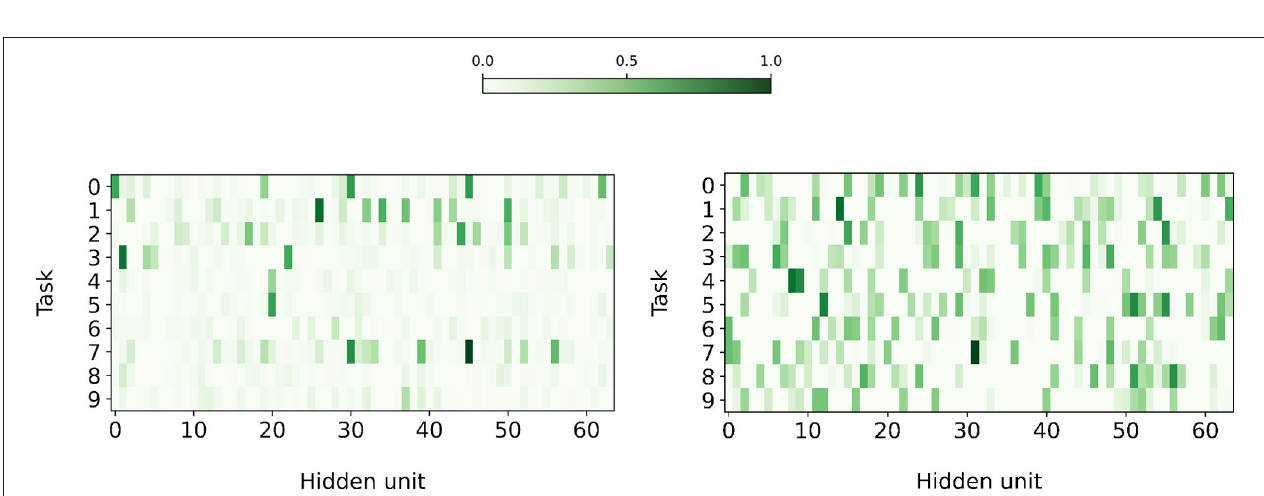
FIGURE 9 | (Left) Final accuracy of the Active Dendrites Network in comparison to XdG when learning 2, 5, 10, 25, 50, and 100 permutedMNIST tasks. The more tasks learned by the system, the greater the accuracy of the Active Dendrites Network. (Right) Final accuracy of each method when augmented with SI, and SI itself. XdG results are taken from Masse et al. (2018).